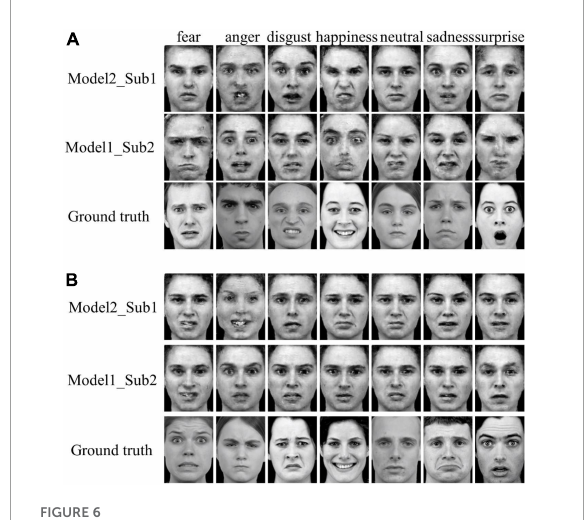
FIGURE6 Inter-subject face reconstruction from functional magnetic resonance imaging (fMRI) signals. (A) Reconstruction of seen faces from brain activities in both subjects. (B) Reconstruction of unseen faces from brain activities in both subjects. Model2_Sub1: Reconstruction of faces from subject 1’s brain activities using the framework trained with subject 2’s fMRI data (top row) ; Model1_Sub2: Reconstruction of faces from subject 2’s brain activities using the framework trained with subject 1’s fMRI data (middle row) . Ground truth: original face image stimuli (bottom row) .